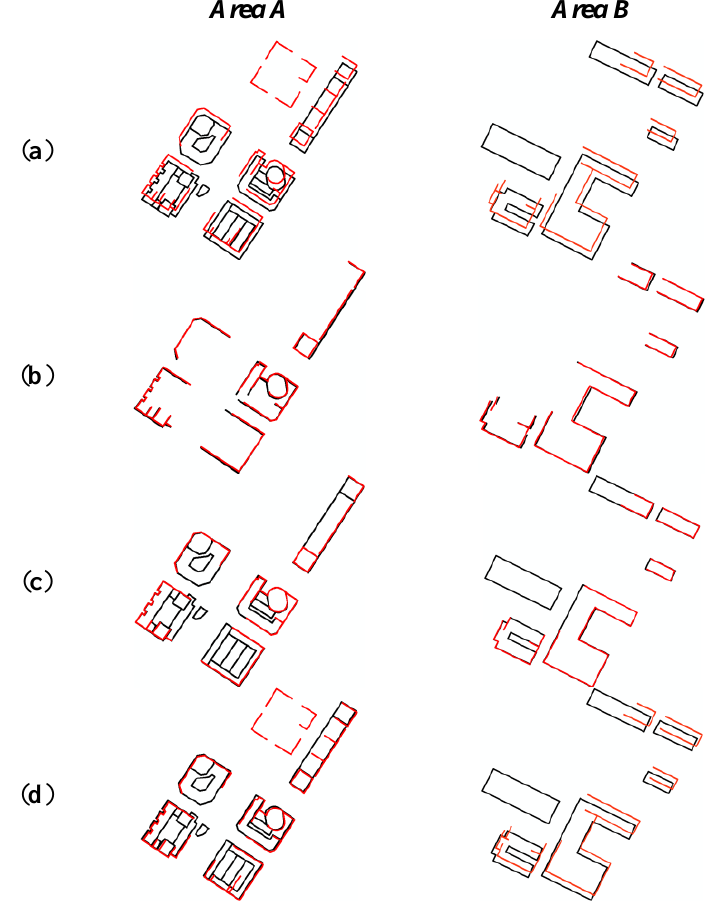
Figure 12. Evaluation on horizontal accuracy using building contours of Area A (left) and Area B (right). ( a ) Result of coarse registration; ( b ) Result by using the conjugate contours; ( c ) Result of fine registration (all airborne contours are retained for visualization); ( d ) ICP refined